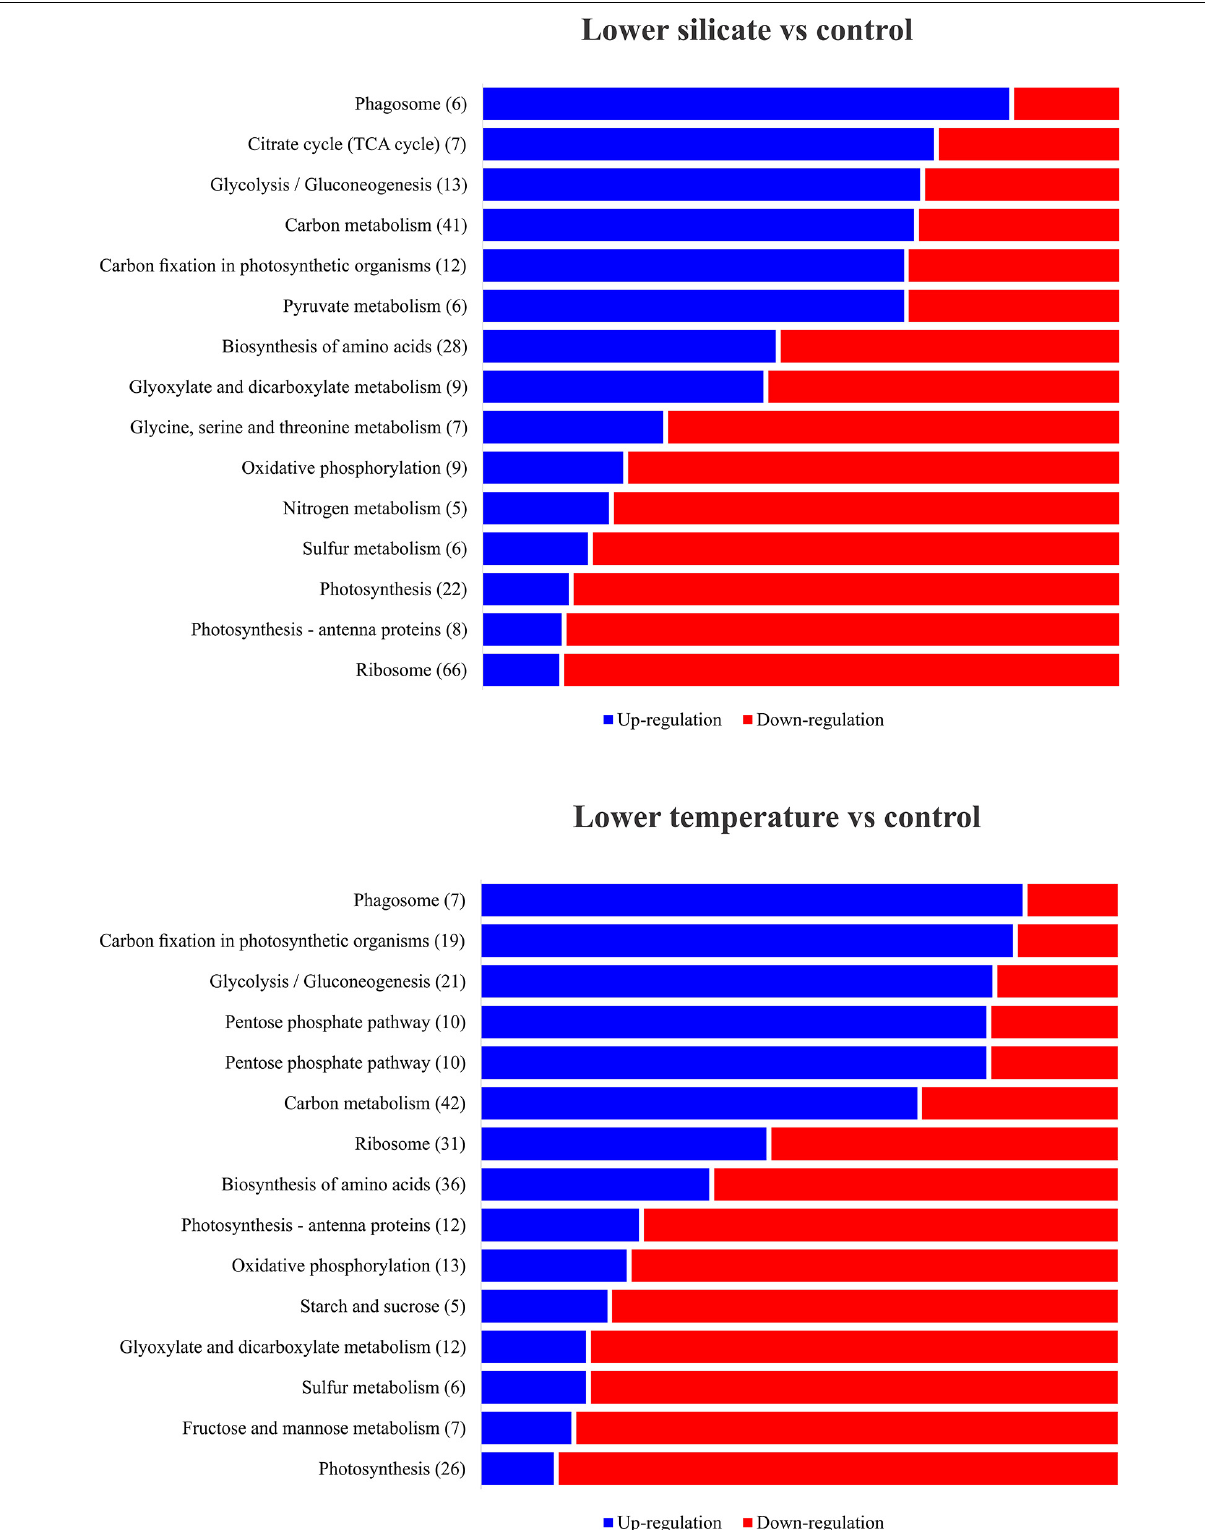
Frontiers in Plant Science |